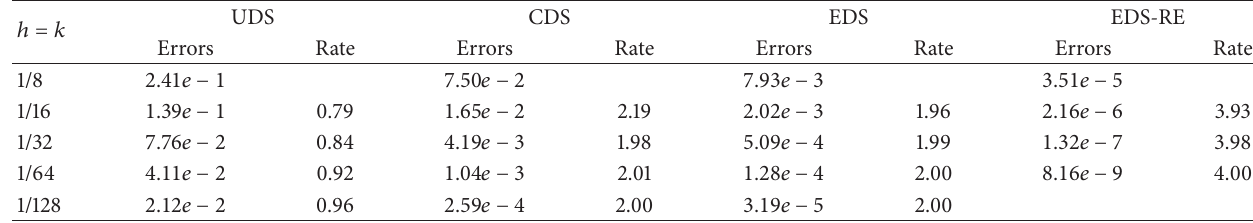
Table 7: Maximum absolute errors and rate in the computed solution, Example 10 with 𝜖 = 0.1 .